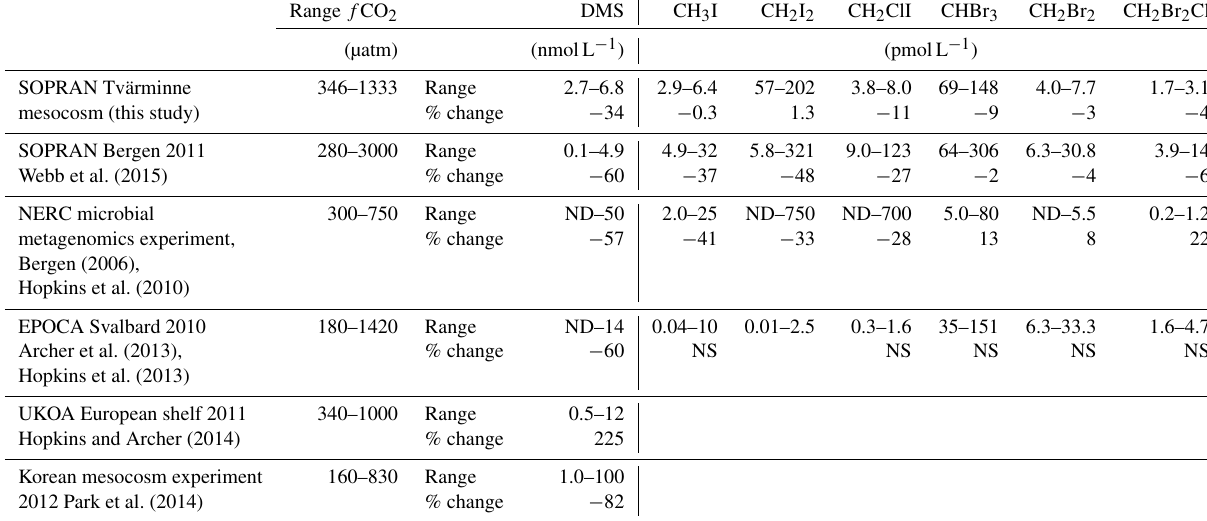
Table 4. Concentration ranges of trace gases measured in the mesocosms compared to other open-water ocean acidification experiments, showing the range of concentrations for each gas and the percentage change between the control and the highest- f CO 2 treatment. SOPRAN: Surface Ocean Processes in the Anthropocene; NERC: Natural Environment Research Council; EPOCA: European Project on OCean Acid- ification; UKOA: UK Ocean Acidification Research